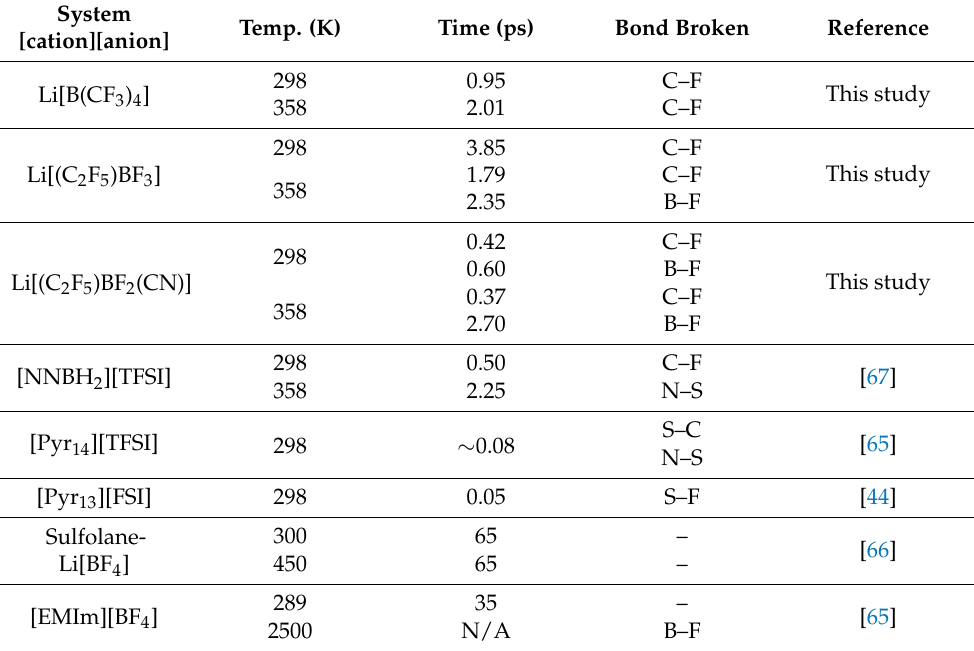
Table 1. The temperature and time when key bonds break in the borate and sulfonamide anions during AIMD simulations on the Li(001)